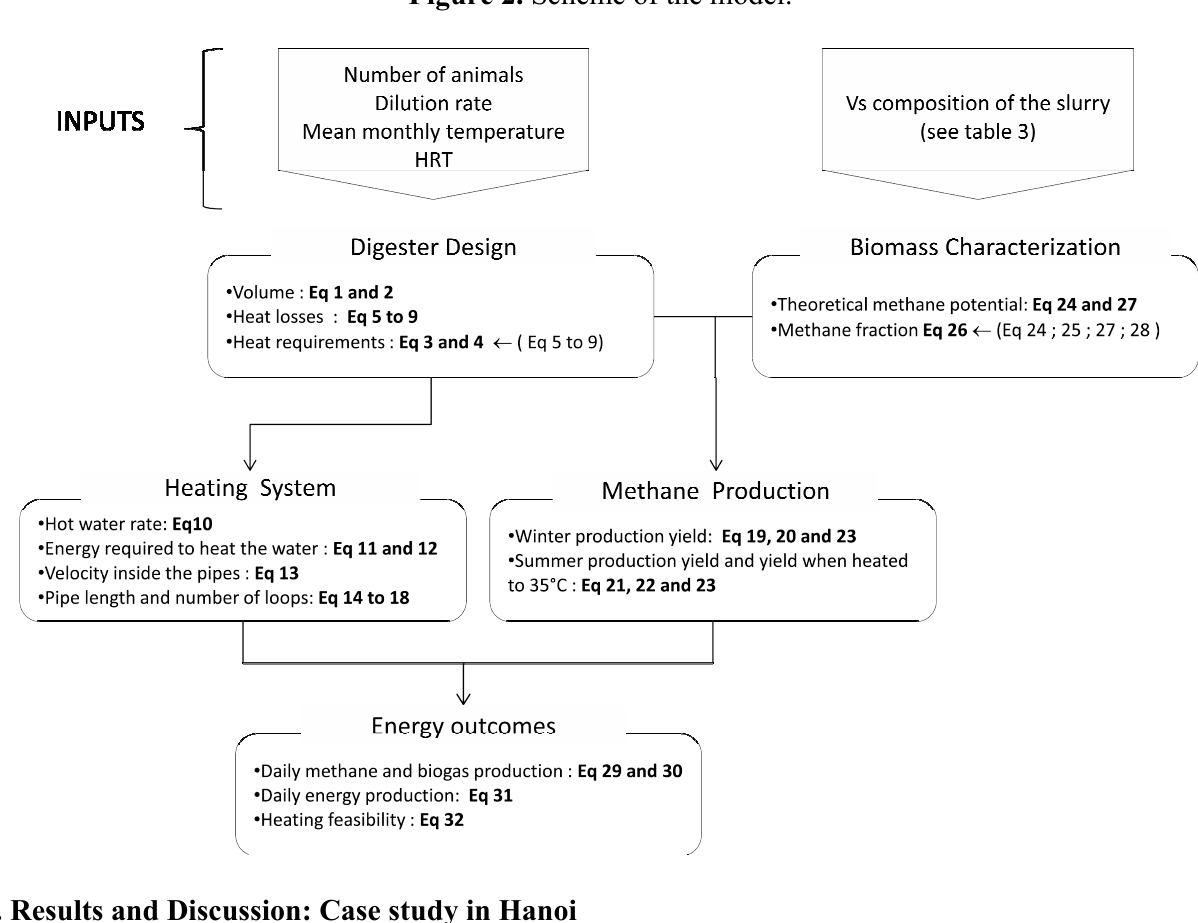
Figure 2. Scheme of the